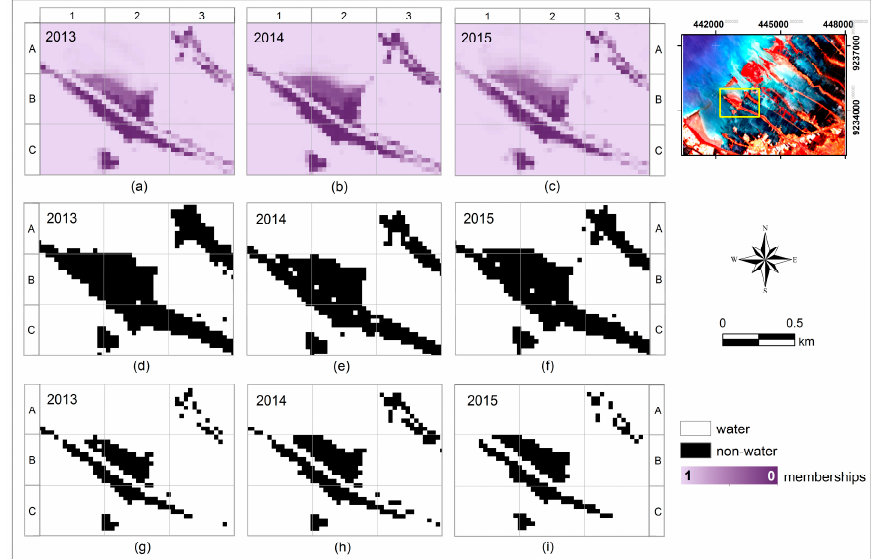
Figure 2. Example of classification results using: FCM ( a – c ); MLC classifier ( d – f ); and hardened classification ( g – i ). ( a – i ) are the detail presentations of yellow rectangle site in the insert map. Hard classification resulted from alternative methods are of limited use in identifying the transition zone between water and non-water, for example, see grid cells, e.g., B1 and B2.